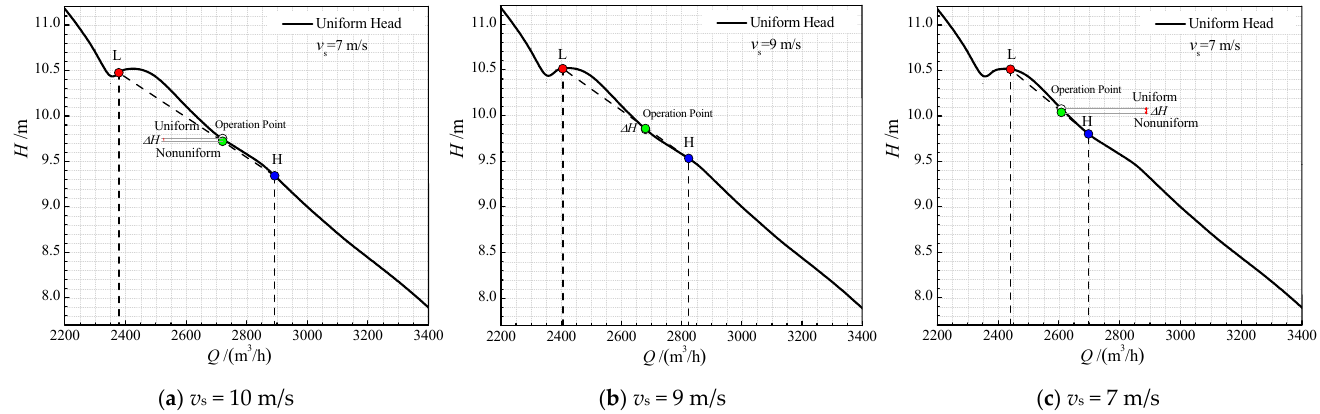
Figure 9. Operating point comparison between tube L and H, at partial stall condition.